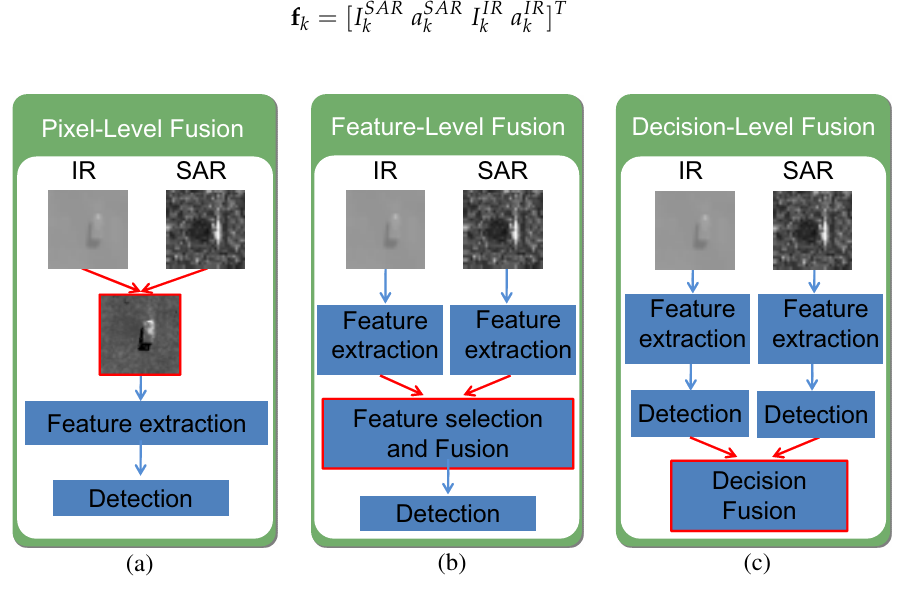
SAR and IR sensor fusion-based target detection schemes: ( a ) pixel-level fusion; ( b ) feature-level fusion; ( c ) decision-level